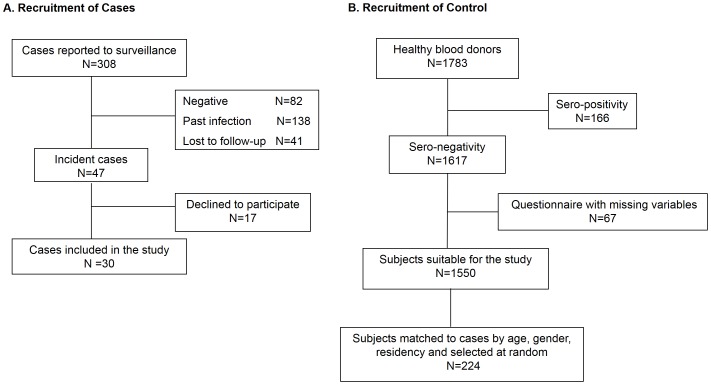
Summary of the recruitment process, which included (A) case and (B) control subject recruitment.